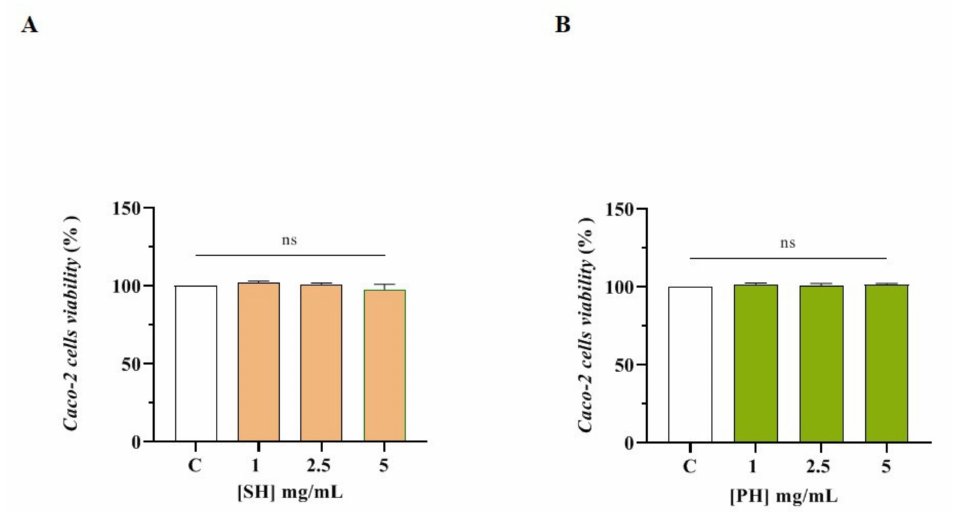
Figure 4. MTT assay. Effect of SH ( A ) and PH ( B ) hydrolysates on Caco-2 cells viability. Data represent the averages ± SD of four independent experiments performed in